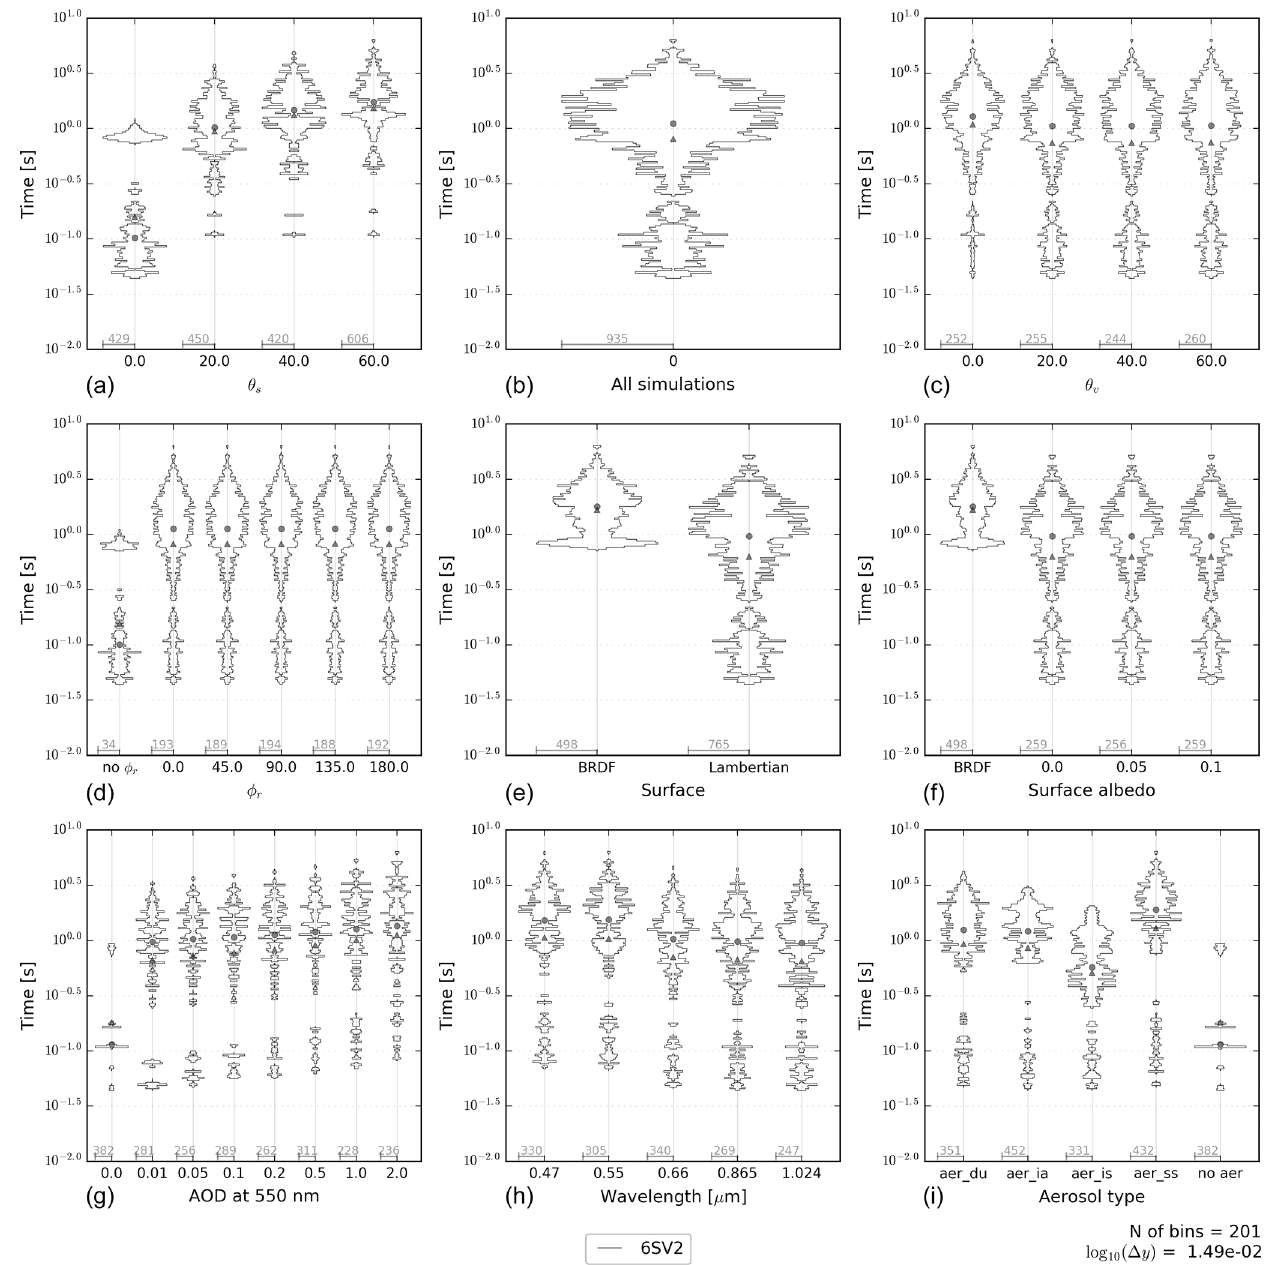
Figure 6. Same as Fig. 3 but for the runtime of the 6SV2 model. Please note the logarithmic scale on the y axis.